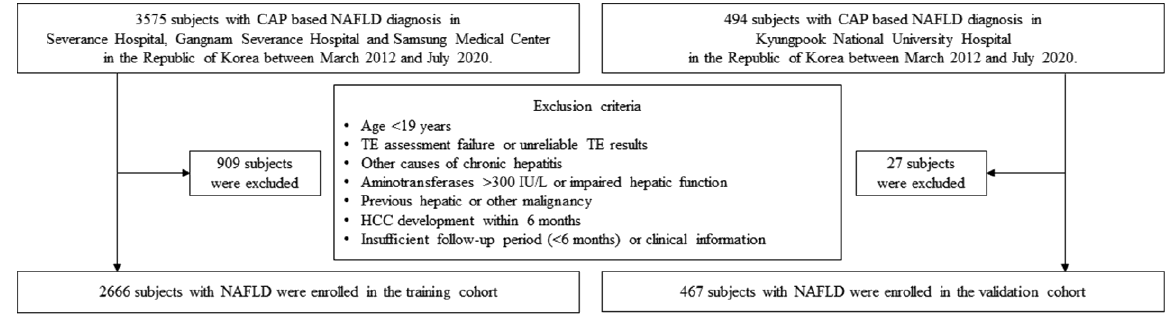
Figure 1. Flow chart of study subject selection. CAP, controlled attenuated parameter; NAFLD, non-alcoholic fatty liver disease; TE, transient elastography; IQR, interquartile range; HCC, hepatocellular carcinoma.